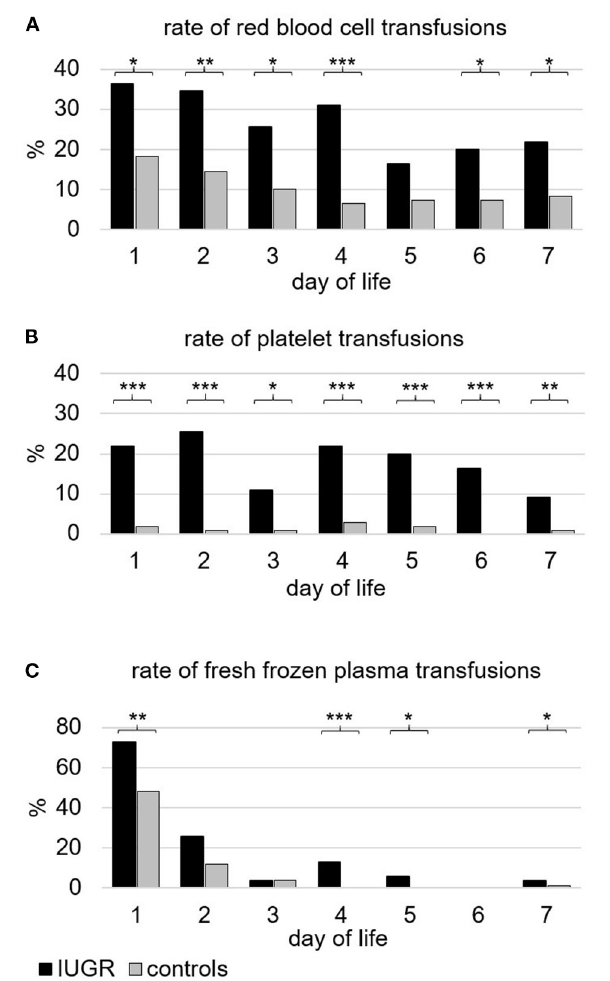
FIGURE 2 | Frequency of infants (%) transfused with different blood components during the first week of life. (A) Packed red blood cells. In total, 83.7% of infants with severe IUGR vs. 52.0% of controls ( p < 0.001) received one or more transfusions of red blood cells. (B) (Apheresis) platelet concentrates. In total, 63.3% of infants with severe IUGR vs. 6.1% of controls ( p < 0.001) received one or more transfusions of platelets. (C) Fresh frozen plasma. In total, 77.6% of infants with severe IUGR vs. 58.2% of controls ( p < 0.01) received one or more transfusions of fresh frozen plasma. Black bars indicate the groups with severe IUGR, gray bars represent the control group. p -values: * p < 0.05; ** p < 0.01; *** p < 0.001, two-sided Fisher exact